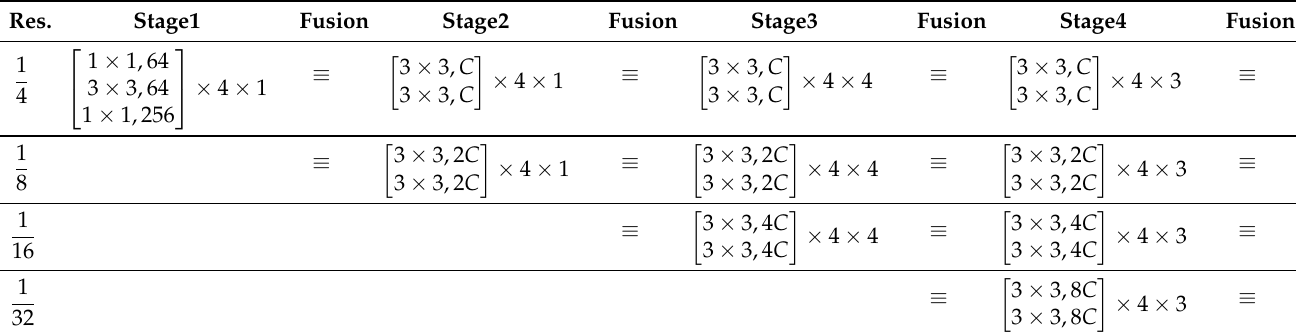
Table 1. The structure of the backbone network of HRNet. It mainly embodies four stages. The 1st (2nd, 3rd, and 4th) stage is composed of 1 (1, 4, and 3) repeated modularized blocks. Meanwhile, each modularized block in the 1st (2nd, 3rd, and 4th) stage consists of 1 (2, 3, and 4) branch(es) belonging to a different resolution. Each branch contains four residual units and one fusion unit. In the table, each cell in the Stage box is composed of three parts: The first part ([ · ]) represents the residual unit, the second number denotes the iteration times of the residual units, and the third number represents the iteration times of the modularized blocks. ≡ in the Fusion column represents the fusion unit. C is the channel number of the residual unit. We set C to 48 and represent the network as HRNet-W48. Res. is the abbreviation of resolution.